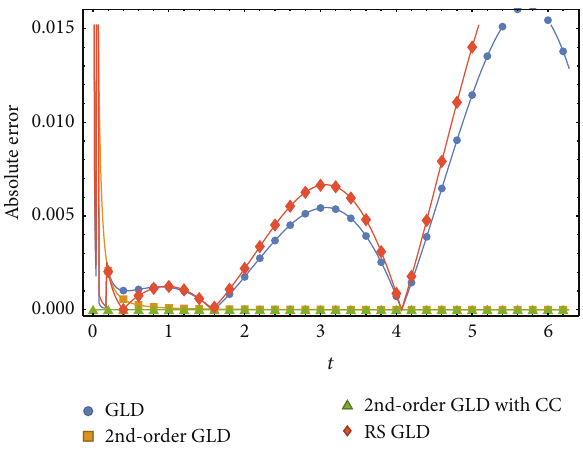
Figure 6: Absolute error over varying values of Δ𝑡 for four different methods.